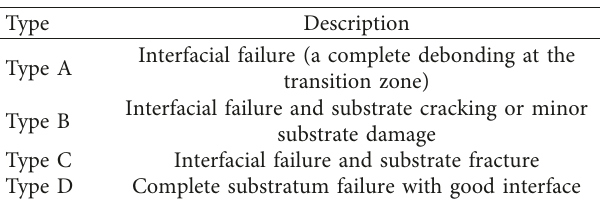
Figure 11: Crack pattern in each specimen: (a) a-1 (crack initiation); (b) a-2 (crack development); (c) a-3 (complete fracture); (d) b-1 (adhesion failure on the external surface); (e) b-2 (development of inner surface detachment); (f) b-3 (complete separation); (g) c-1 (crack initiation); (h) c-2 (crack development); (i) c-3 (complete fracture); (j) d-1 (crack initiation); (k) d-2 (crack development); (l) d-3 (complete Table 7: Failure mode classifications.